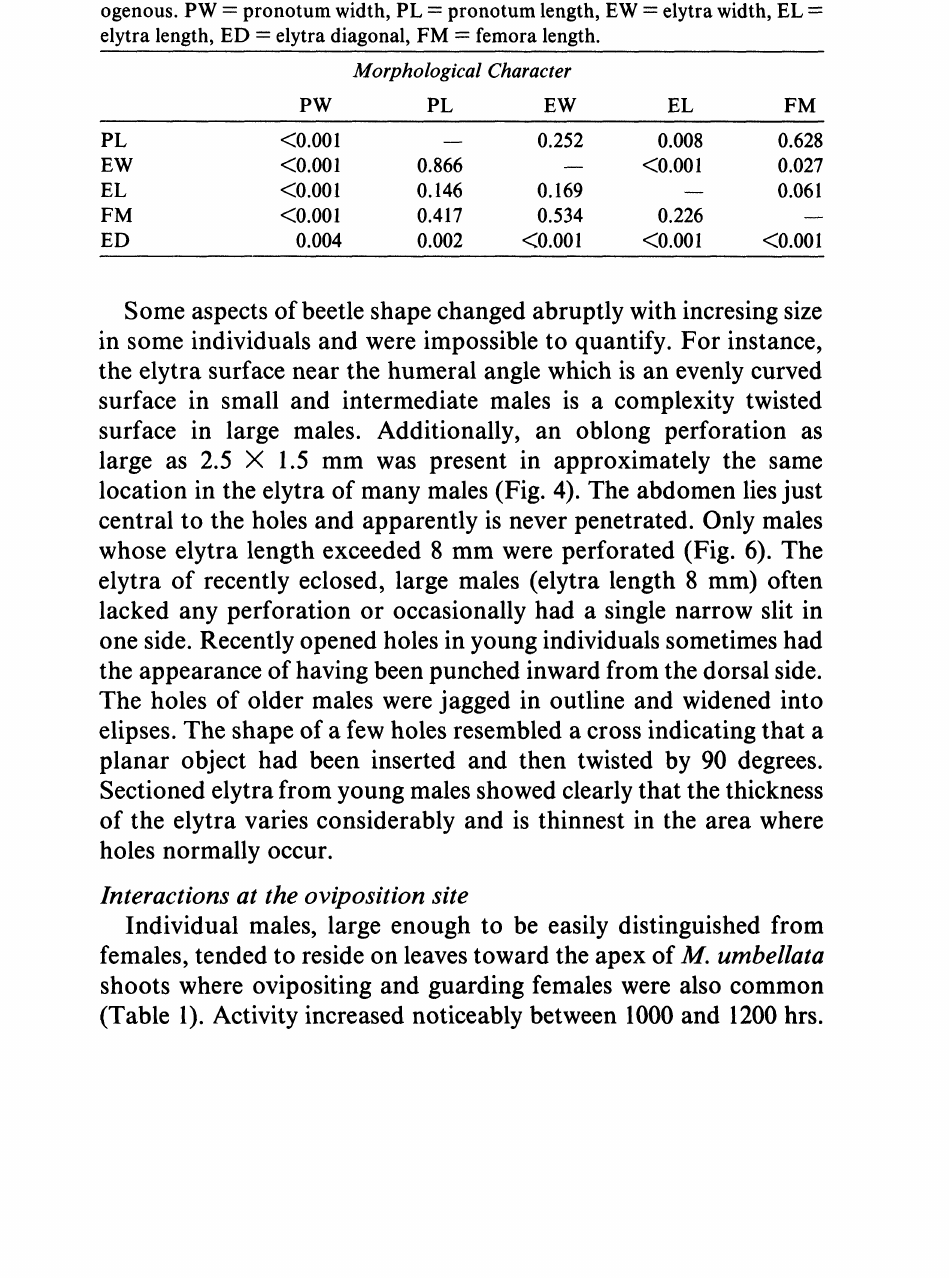
Table 4. The lower left portion of the matrix contains the probabilities that male and female regression lines in each comparison have the same slope. The upper right portion contains probabilities that male and female regression lines have the same intercept. Intercepts have been computed only for those cases where slopes are hom- ogenous.